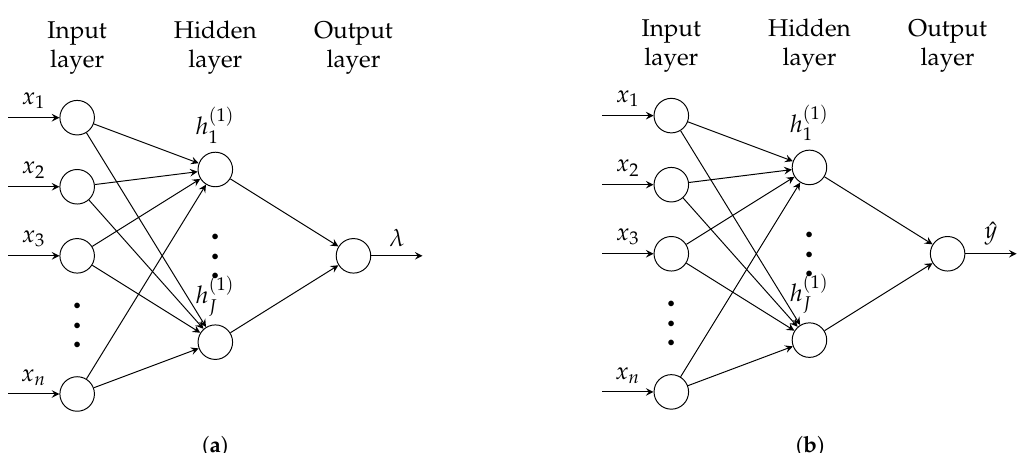
Figure 6. Examples of neural network architectures for exponential family (EF) distributions. ( a ) An approach for nonlinear Poisson regression. ( b ) The approach proposed by Denuit et al. (2019a).